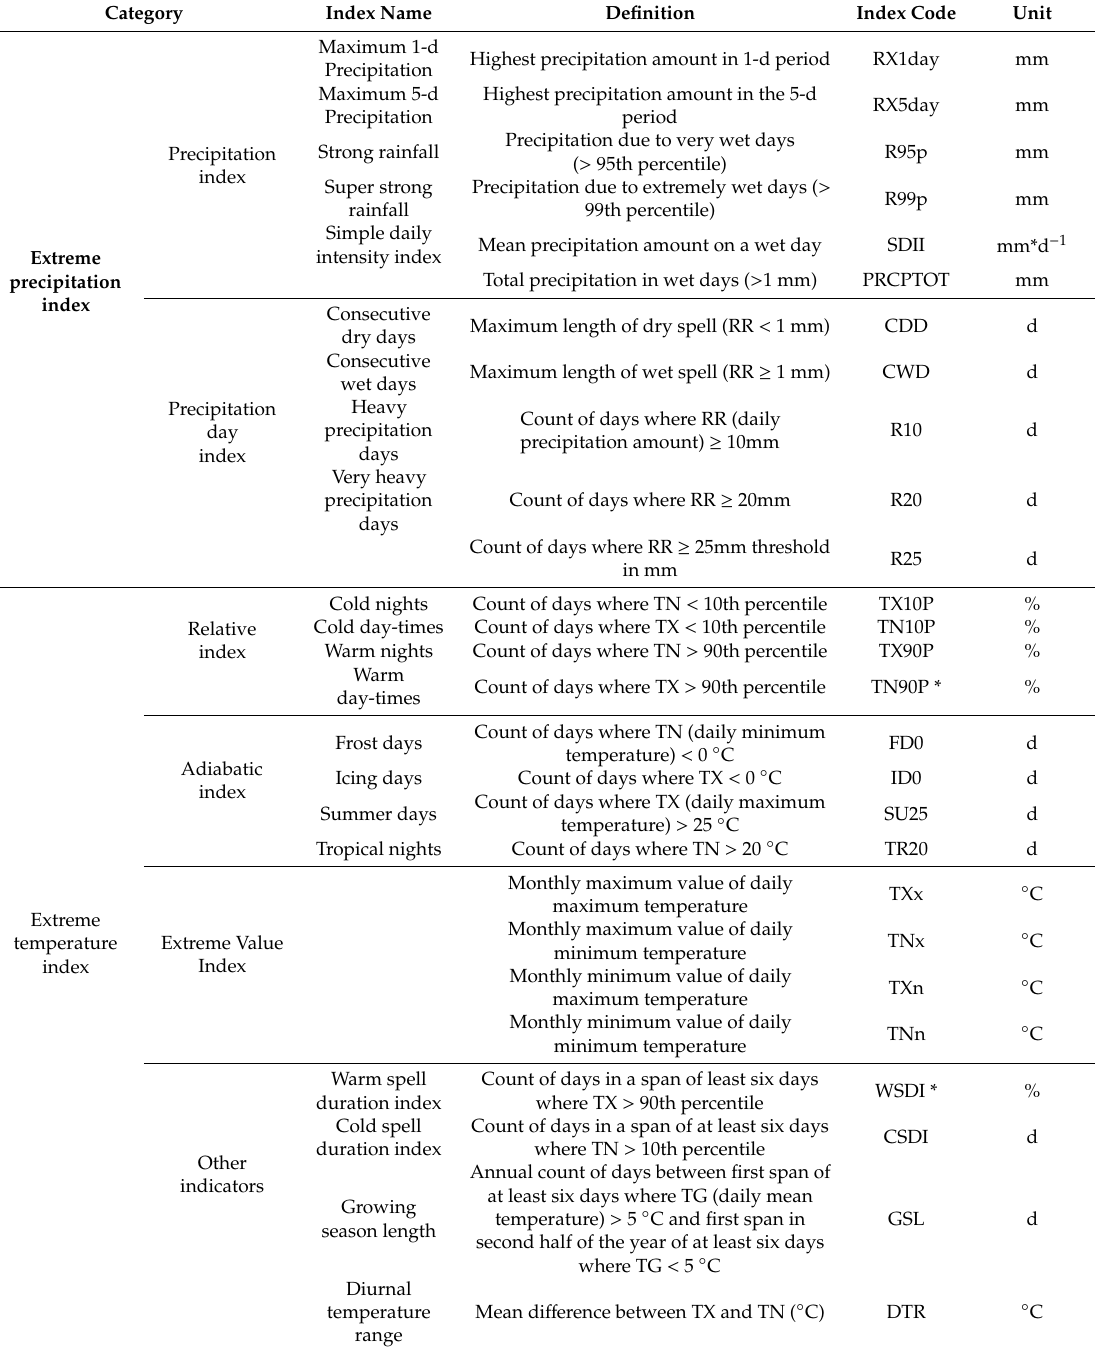
Table 2. Definition and classification of extreme climatic indices from the RClimDex